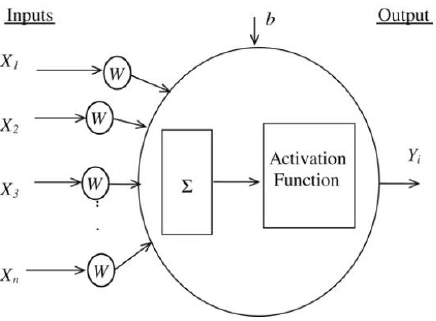
Figure 2. Schematic configuration of the basic structure of a node in ANN [43].